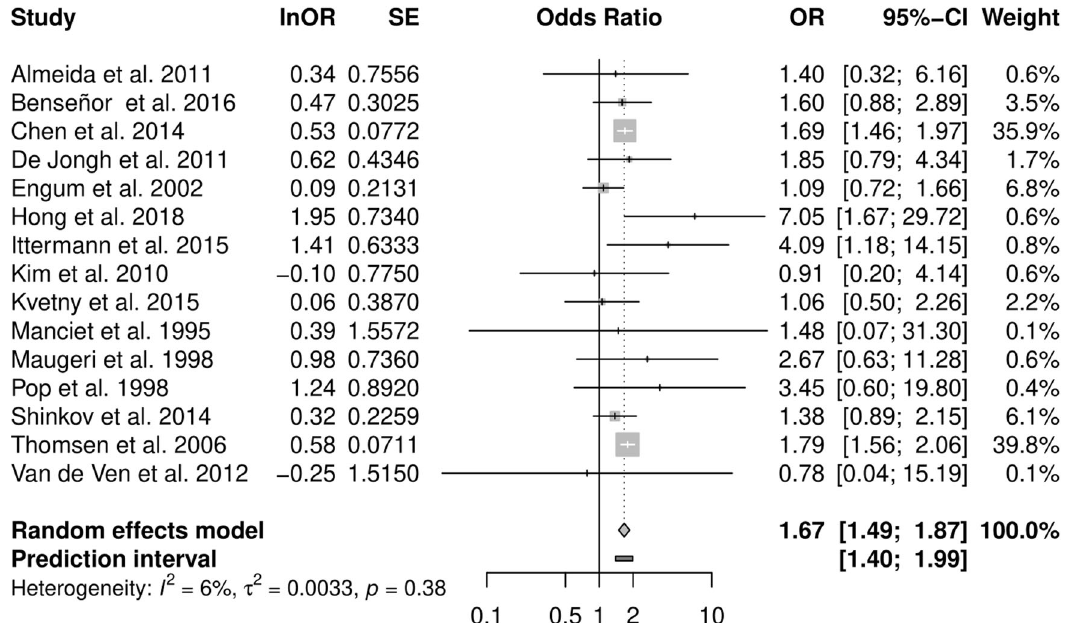
Fig. 2 Association of hyperthyroidism and depression. Forest plot of the primary analysis on the association of hyperthyroidism and depression. Odds ratios greater than 1 indicate a stronger association of depression with hyperthyroidism than with euthyroidism, odds ratios smaller than 1 indicate a weaker association.